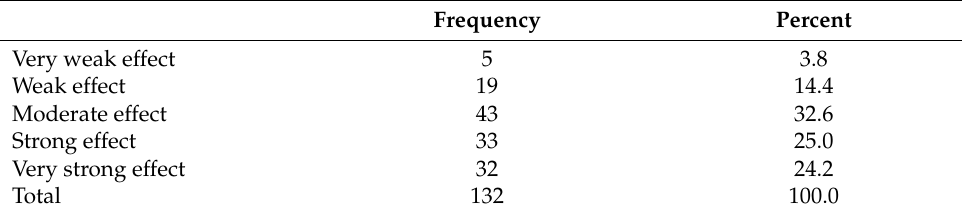
Table 12. Valuer